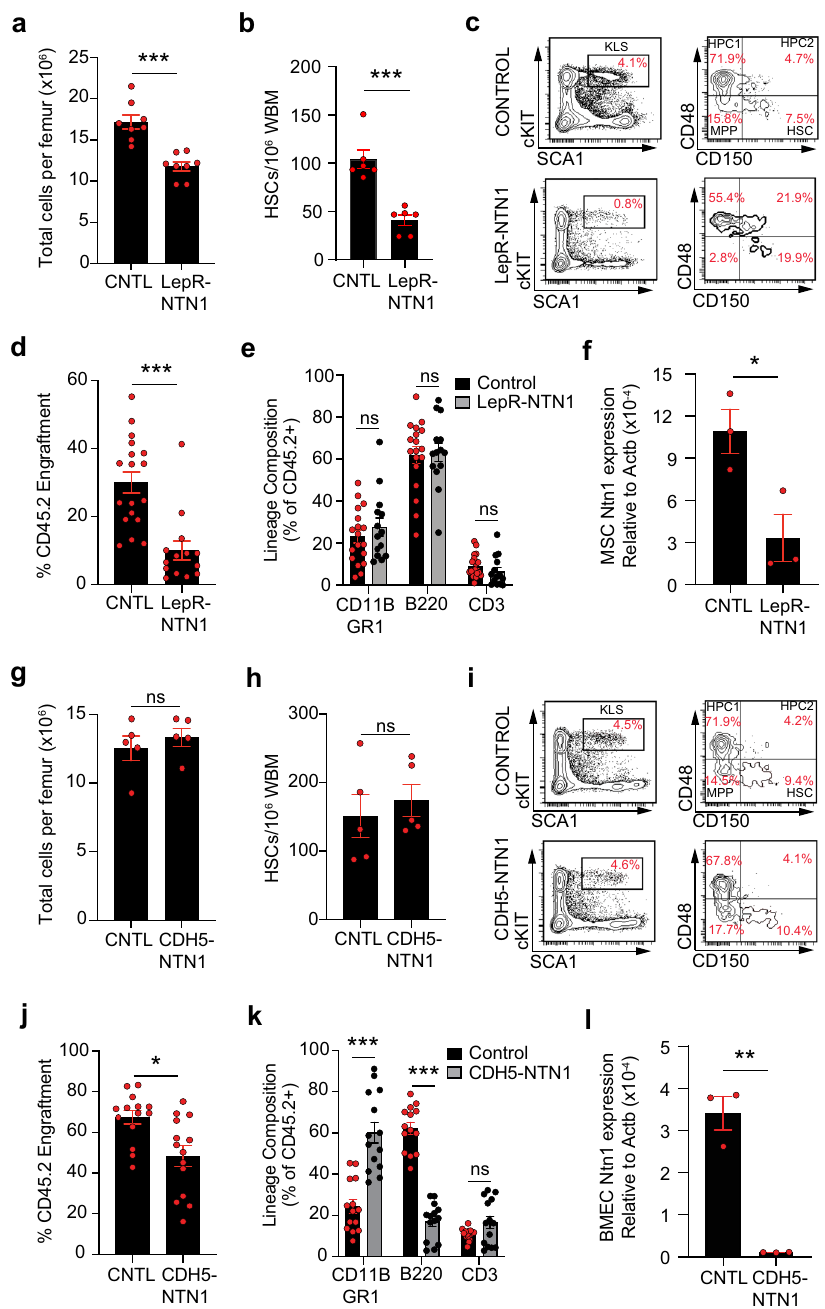
Fig. 3 | BM niche derived NTN1 is essential for maintaining HSC homeostasis. a – c BM analysis in young (5-6 month old) LepR-NTN1 mice demonstrating a decreaseinBMcellularity a (N=8mice/group),andHSCfrequency b , c ( N =6mice/ group), as compared to littermate controls. d , e Competitive HSCtransplantations (250 CD45.2+ donor HSCs with 10 6 CD45.1 WBM competitor/recipient) demon- stratingalossoflong-term(>6monthspost-transplant)HSCengraftmentpotential d withoutlineagealterations e inHSCsderivedfrom LepR-NTN1 mice( N =6donors/ group; N =18 Recipients for Control donors, N =14 Recipients for LepR-NTN1 donors). f RT-qPCR analysis of FACS puri fi ed LepR+ MSCs demonstrating decreased NTN1expression in LepR-NTN1 mice ( N =3mice/group). g – i BManalysis